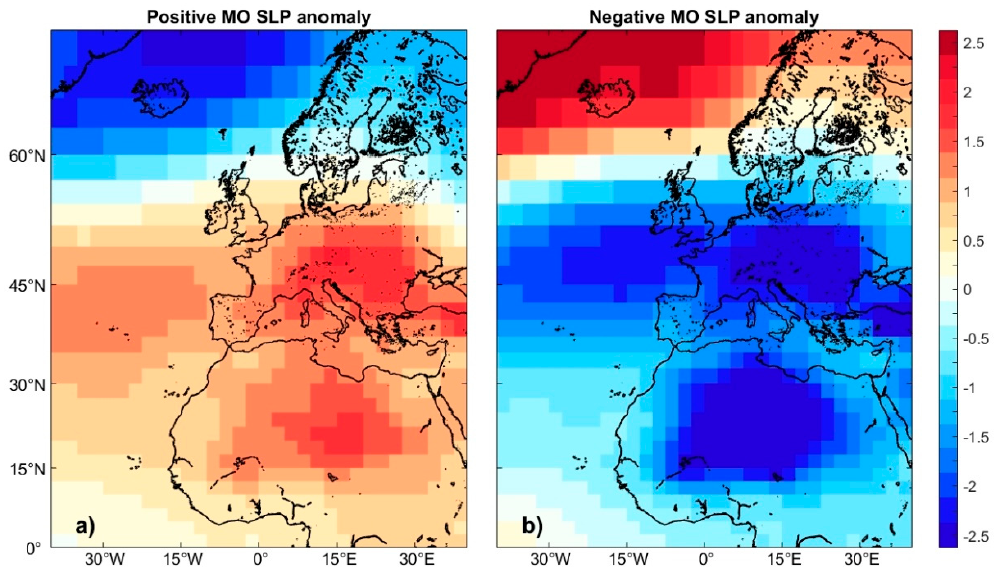
Figure 5. Composites of sea level pressure anomalies (mbar) in the period 1948–2008. Panel ( a ) reflects the positive phase (higher quartile) and panel ( b ) the negative phase (lower quartile) of the MO.